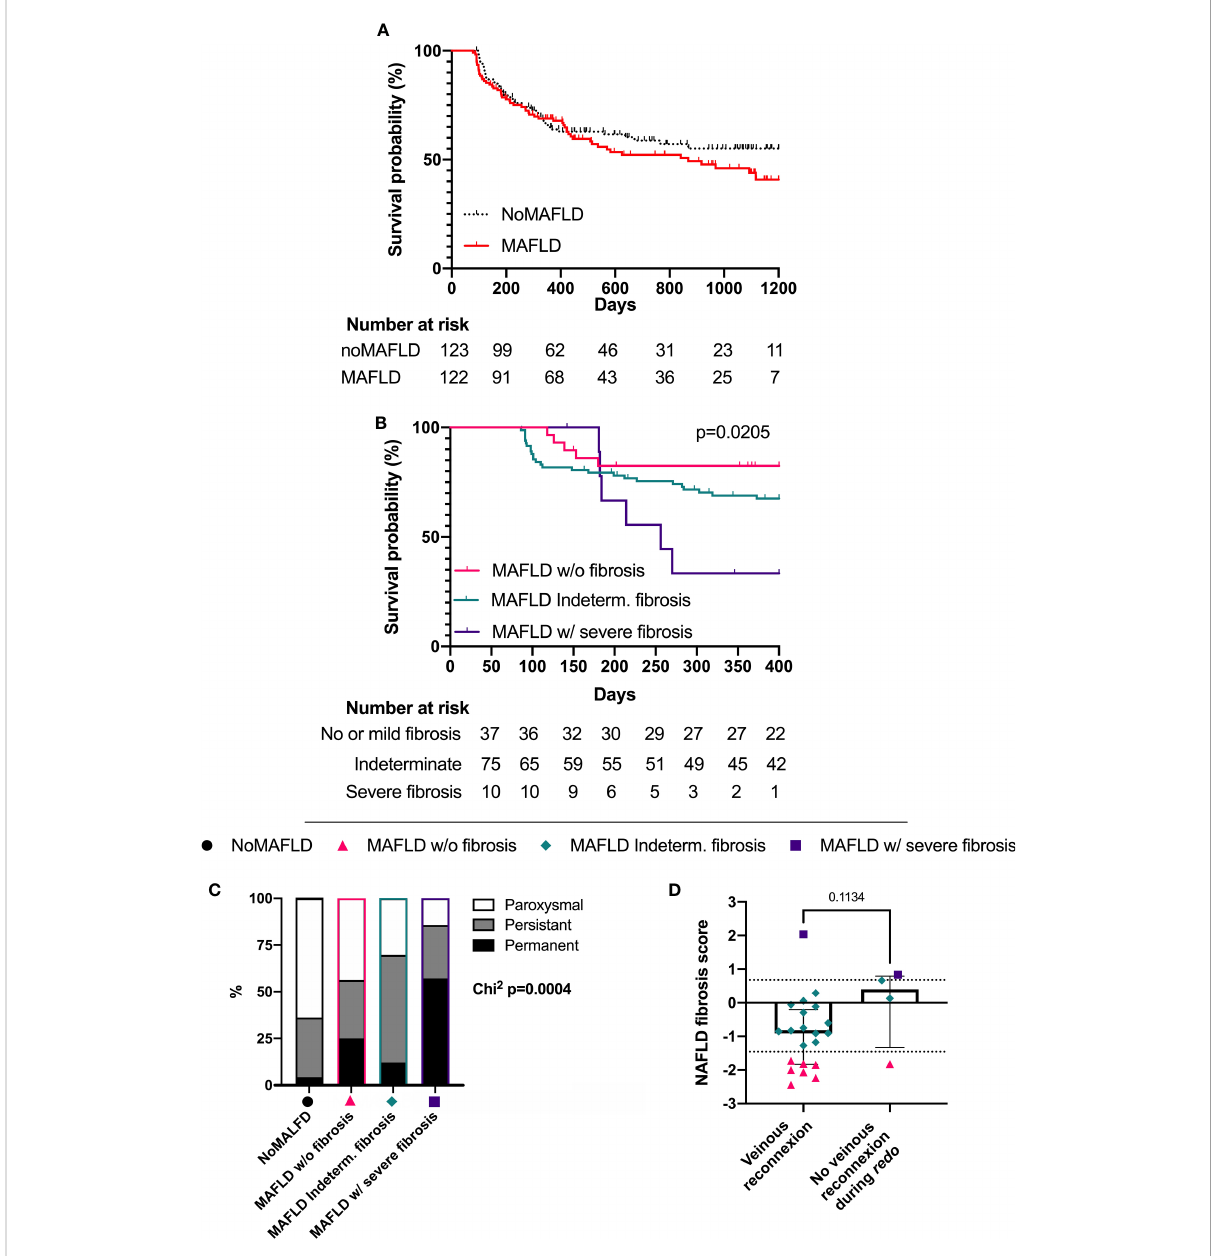
FIGURE 3 AF recurrence burden according to liver status. Atrial fi brillation recurrence after fi rst ablation according to the MAFLD status (A) and liver fi brosis status in MAFLD patients (B) . Atrial fi brillation recurrence subtype (NoMAFLD n = 47; MAFLD w/o fi brosis n = 16; MAFLD ind. fi brosis n = 33; MAFLD w/severe fi brosis n = 7) (C) and recurrence mechanism according to the NAFLD Fibrosis Score (D) . NoMAFLD: FLI < 60; MAFLD w/o fi brosis: FLI > 60 and NFS < 1.455; MAFLD ind. fi brosis: FLI > 60 and − 1.455 < NFS < 0.675; MAFLD w/severe fi brosis: FLI > 60 and NFS > 0.675. Survival analysis: log-rank (Mantel – Cox) if two groups (A) or log-rank for trend if more than two groups (B) ; chi-squared for trend (C) ; Mann – Whitney test (D) . Median ± interquartile range ; dashed lines represent the validated NFS cutoffs of − 1.455 and 0.675 (D) . MAFLD, metabolic dysfunction- associated fatty liver disease; NAFLD, non-alcoholic fatty liver